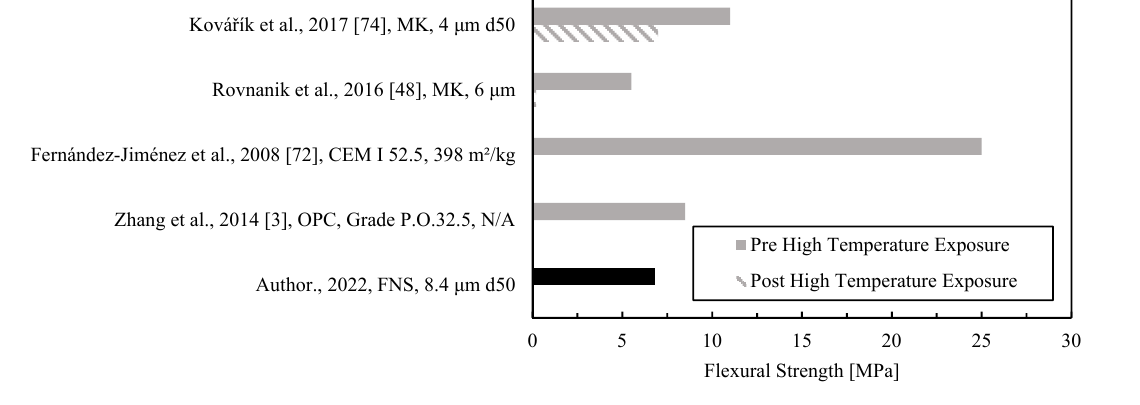
Figure 9. Flexural strength of low-calcium AAM pastes after exposure to a thermal load between 800 and 1000 ◦